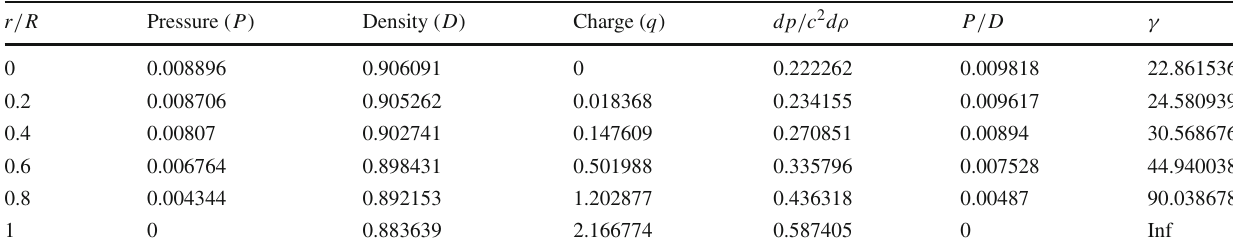
Table 2 Values of the model parameters K = 0 . 0033 , C 1 = − 0 . 001 , β 2 = 4 . 83 , b = 0 . 05 , z o = 0 . 307064 , z s = 0 . 197225